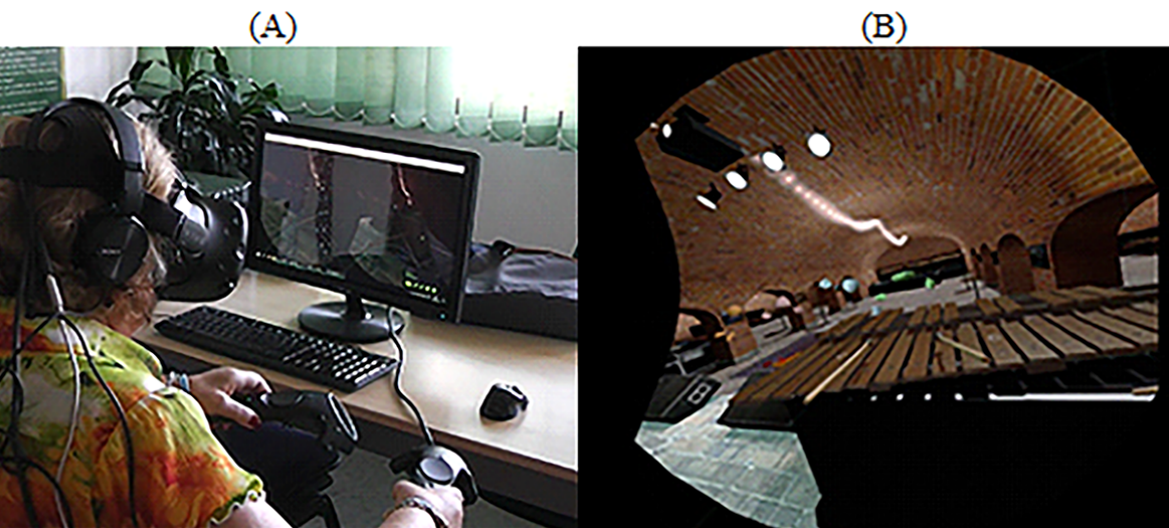
Figure 6. Steam virtual reality home—Playing musical instruments. (A) Playing the xylophone using head-mounted display with controllers. (B) Print screen of the game. Wooden xylophone with wooden sticks and dancing avatars.